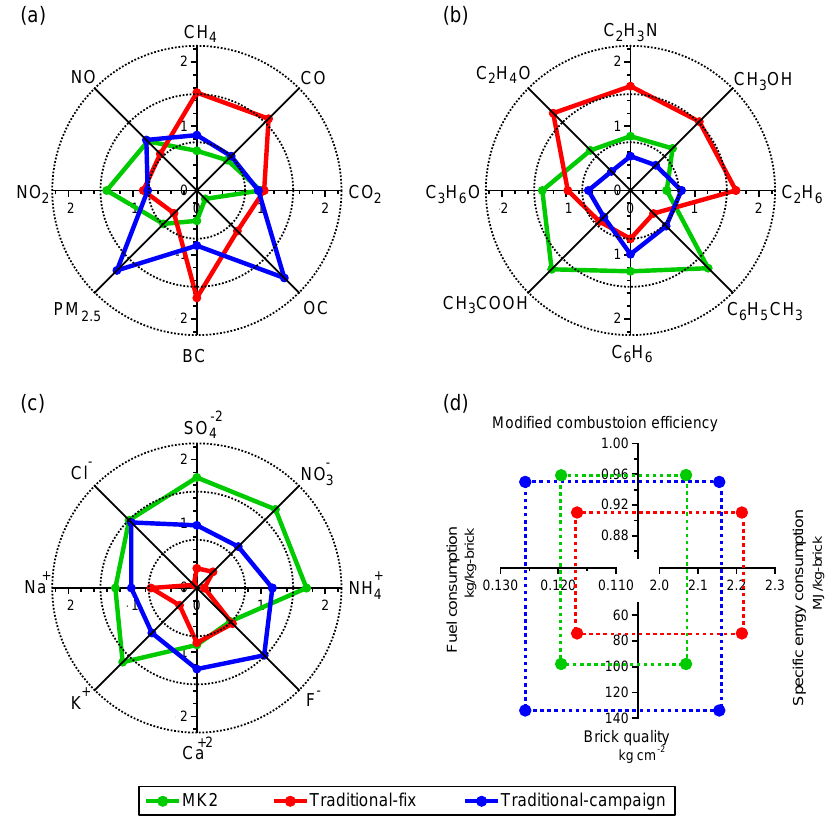
Figure 4. Inter-comparison of emission factors normalized to the average of the three kilns by pollutant for (a) CO, CO 2 , NO, NO 2 , OC, BC, PM 2 . 5 , CH 4 ; (b) sampled VOC species; and (c) inorganic components. Panel (d) compares the modified combustion efficiency, specific energy consumption, fuel consumption, and brick quality for the three sampled